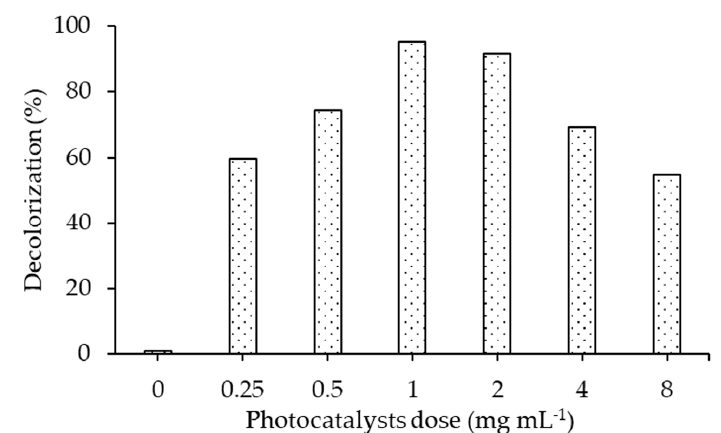
Figure 9. E ff ect of di ff erent photocatalyst dose on the decolorization of RB5 dye using 20N–TiO 2 Figure 9. Effect of different photocatalyst dose on the decolorization of RB5 dye using 20N–TiO 2 calcined at 300 ◦ C, (Reaction conditions: dye conc. 30 mg L − 1 , reaction temperature 22 ◦ C, pH 6.8). calcined at 300 °C, (Reaction conditions: dye conc. 30 mg L − 1 , reaction temperature 22 °C, pH 6.8).